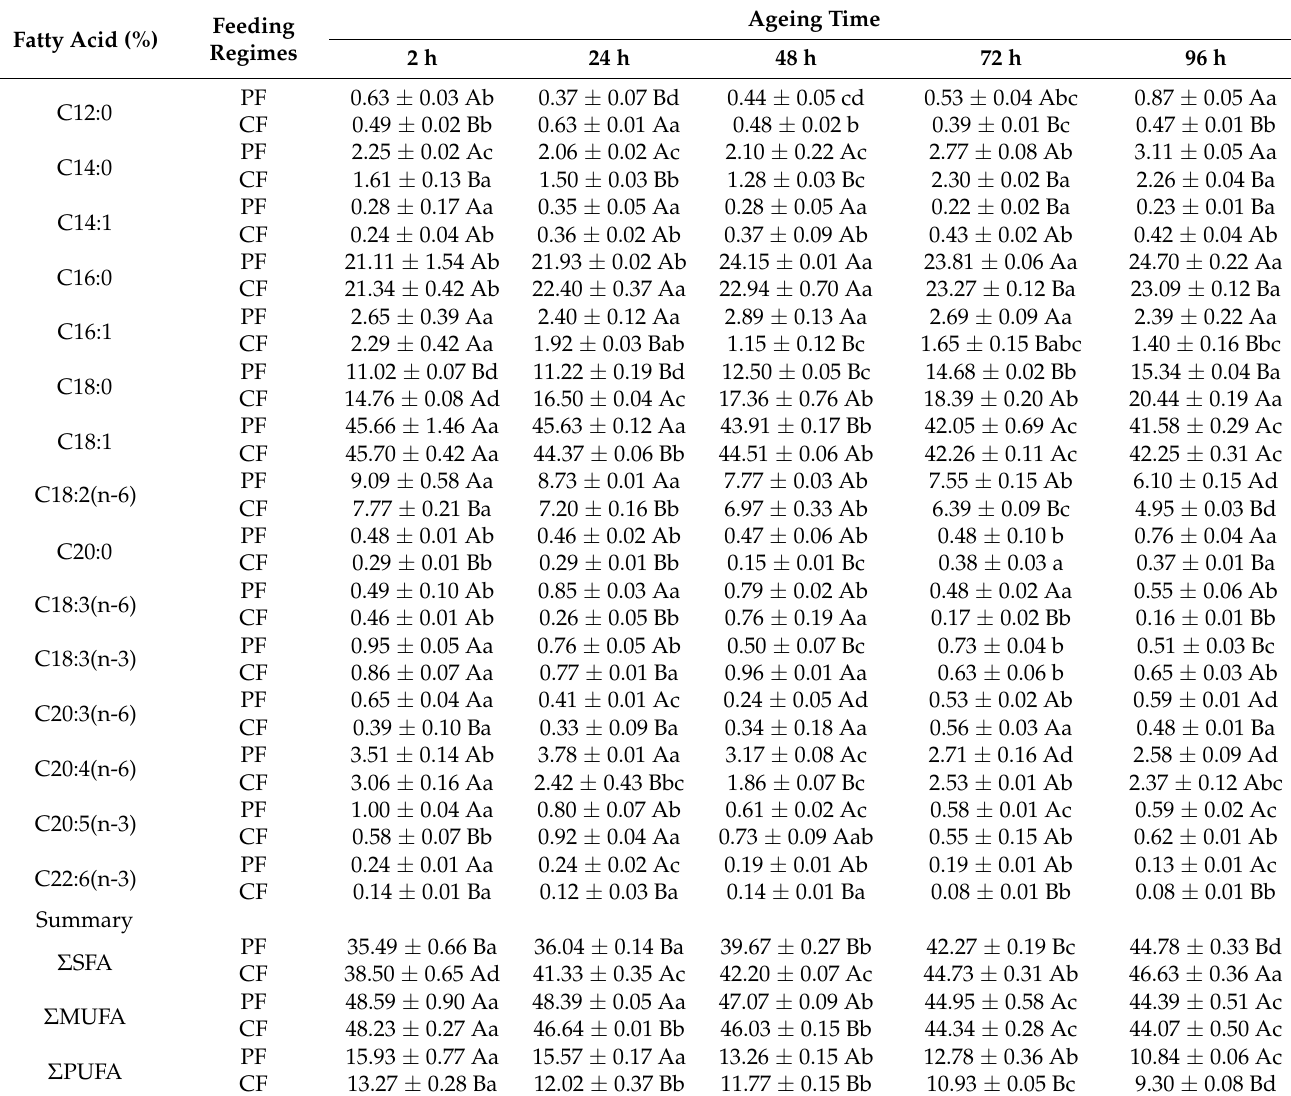
Table 3. Effects of different feeding regimes and postmortem aging times on the fatty acid composition and levels in the LT muscles of